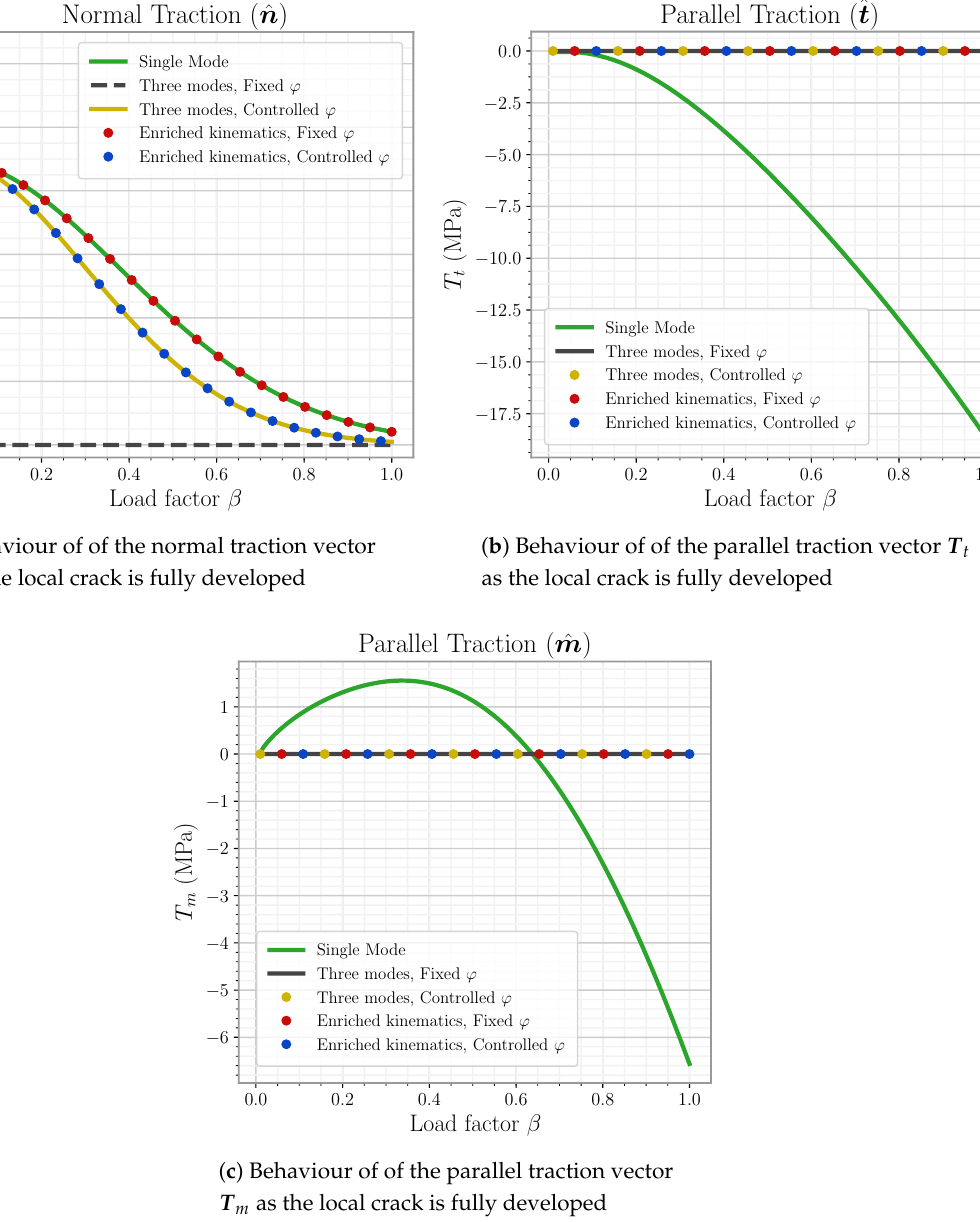
Figure 15. Comparison of the fracture traction components response for all five formulations. In ( a ), the behaviour of the normal traction component T n is shown, while ( b ) and ( c ) show the parallel components T t and T m ,